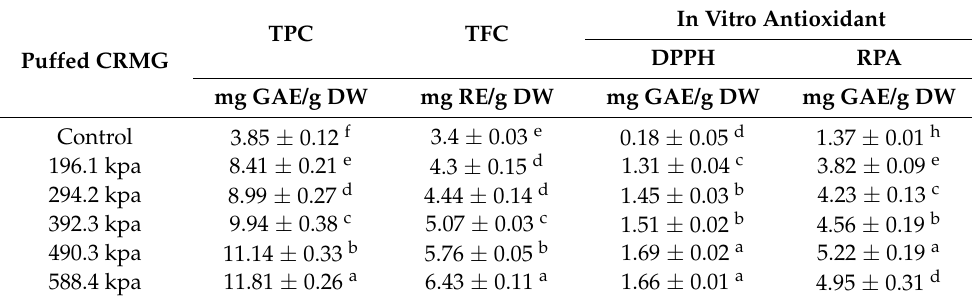
Table 4. The contents of TPC, TFC and antioxidant activities (including DPPH and RPA) of puffed